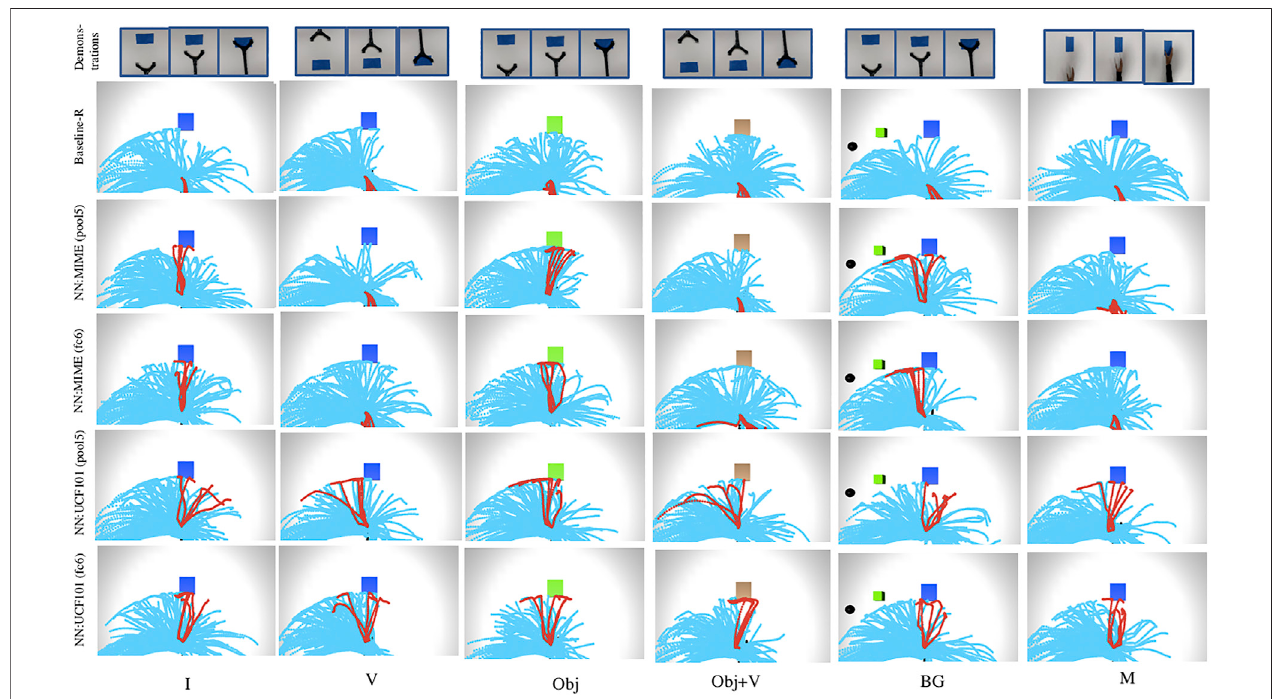
FIGURE 6 | Trajectory maps obtained during reinforcement learning of the task of reaching, when O 2 A action vector extractors are pre-trained with UCF101 dataset[NN:UCF101(pool5,fc6)]andwithMIMEdataset[NN:MIME(pool5,fc6)].NN:UCF101provideshighrewardsfordesiredtrajectoriesforallthedomainshifts(I,V, Obj, Obj+V, BG, M). However, NN:MIME performs poorly when viewpoint of observation (V, Obj+V) and morphology of the manipulator (M) changes.